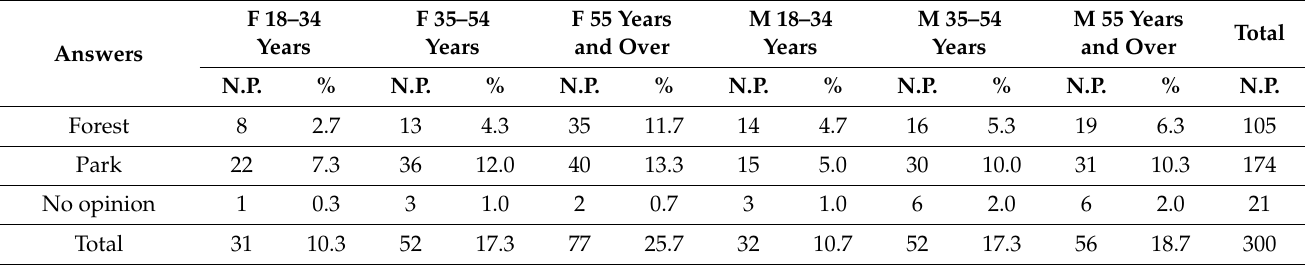
Table 5. Respondents’ answers (by sex and age) to the question: should this area be better managed (alleys, lighting, recreation)? (Source: the